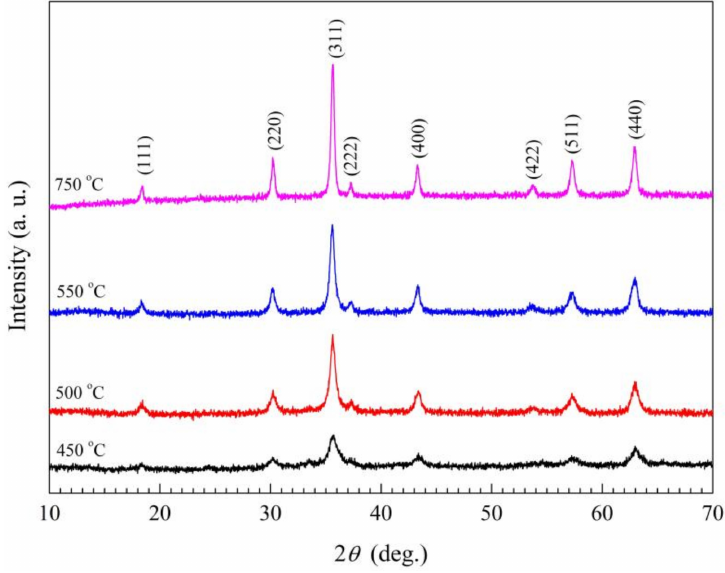
Figure 5. The XRD patterns of the calcined powders of S4 ceramic